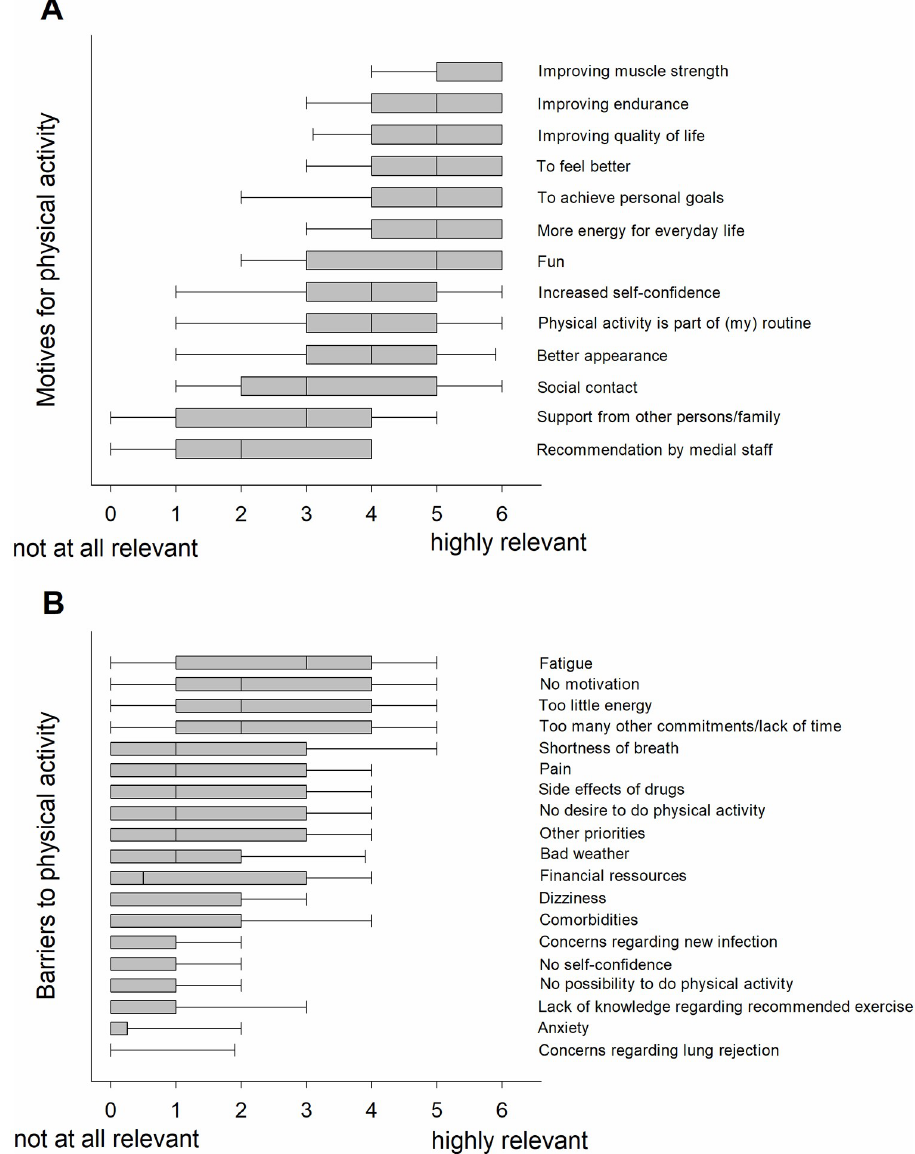
Fig 1. Motives (A) and barriers (B) to physical activity (PA) in lung transplant recipients with cystic fibrosis (CF). Boxplots indicate median values with interquartile ranges (25 th and 75 th percentiles) and error bars. Motives and barriers to PA are sorted (top to bottom) according to the highest median values (i.e., highest values on the 0–6 Likert scale). ( p = 0.003), self-care ( p = 0.016), and usual activities ( p = 0.026), while the dimensions pain/ discomfort ( p = 0.878) and anxiety/depression ( p = 0.256) were not different between groups.